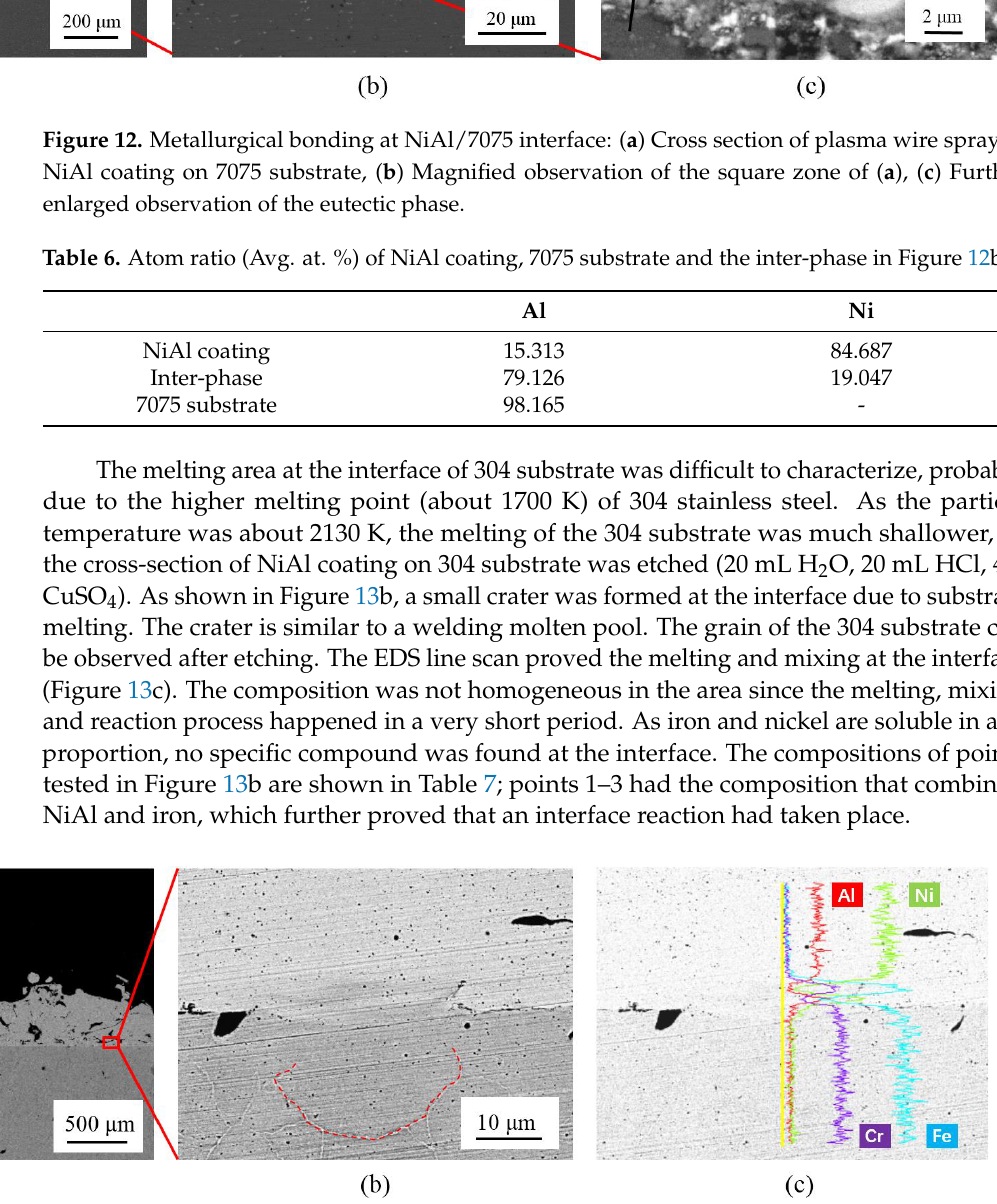
Figure 13. NiAl/304 interface: ( a ) Plasma wire sprayed NiAl coating on 304 substrate, ( b ) Magnified observation of the square zone of ( a ), ( c ) EDS line scan across the interface. Table 7. Compositions (wt. %) of points at NiAl/304 interface.